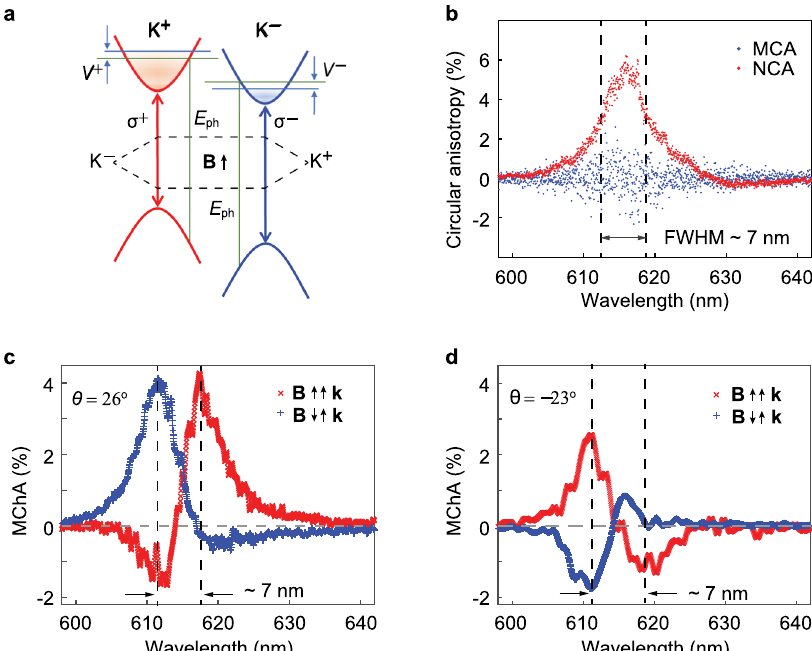
Fig. 4 The strong excitonic magneto-chiral anisotropy. a The schematic of the magneto-chiral effect that lifts the degeneracy and exerts a population difference to the two valleys simultaneously. b Circular anisotropy spectra for σ − and σ + excitons at room temperature. The natural circular anisotropy (NCA) spectrum (red) extracted from the same sample in Fig. 2c that situated on an oxidized silicon substrate possesses a signi fi cant peak with the full width at half maximum (FWHM) of ~7 nm, signifying the chirality. The circular anisotropy spectrum (blue) induced by the spontaneous magnetic fi eld (MCA) for an ML-WS 2 on TIG is zero at all wavelengths. The magneto-chiral anisotropy (MChA) spectra for a twisting angle of 26° ( c ) and − 23° ( d ) show opposite spectral behaviors, except both of them, contain a peak and a dip with a spectral distance precisely the same as the FWHM of NCA in b . Moreover, for both c and d , when the spontaneous magnetic fi eld fl ip from parallel (red cross) to antiparallel (blue plus) to the wavevector k , the spectra also fl